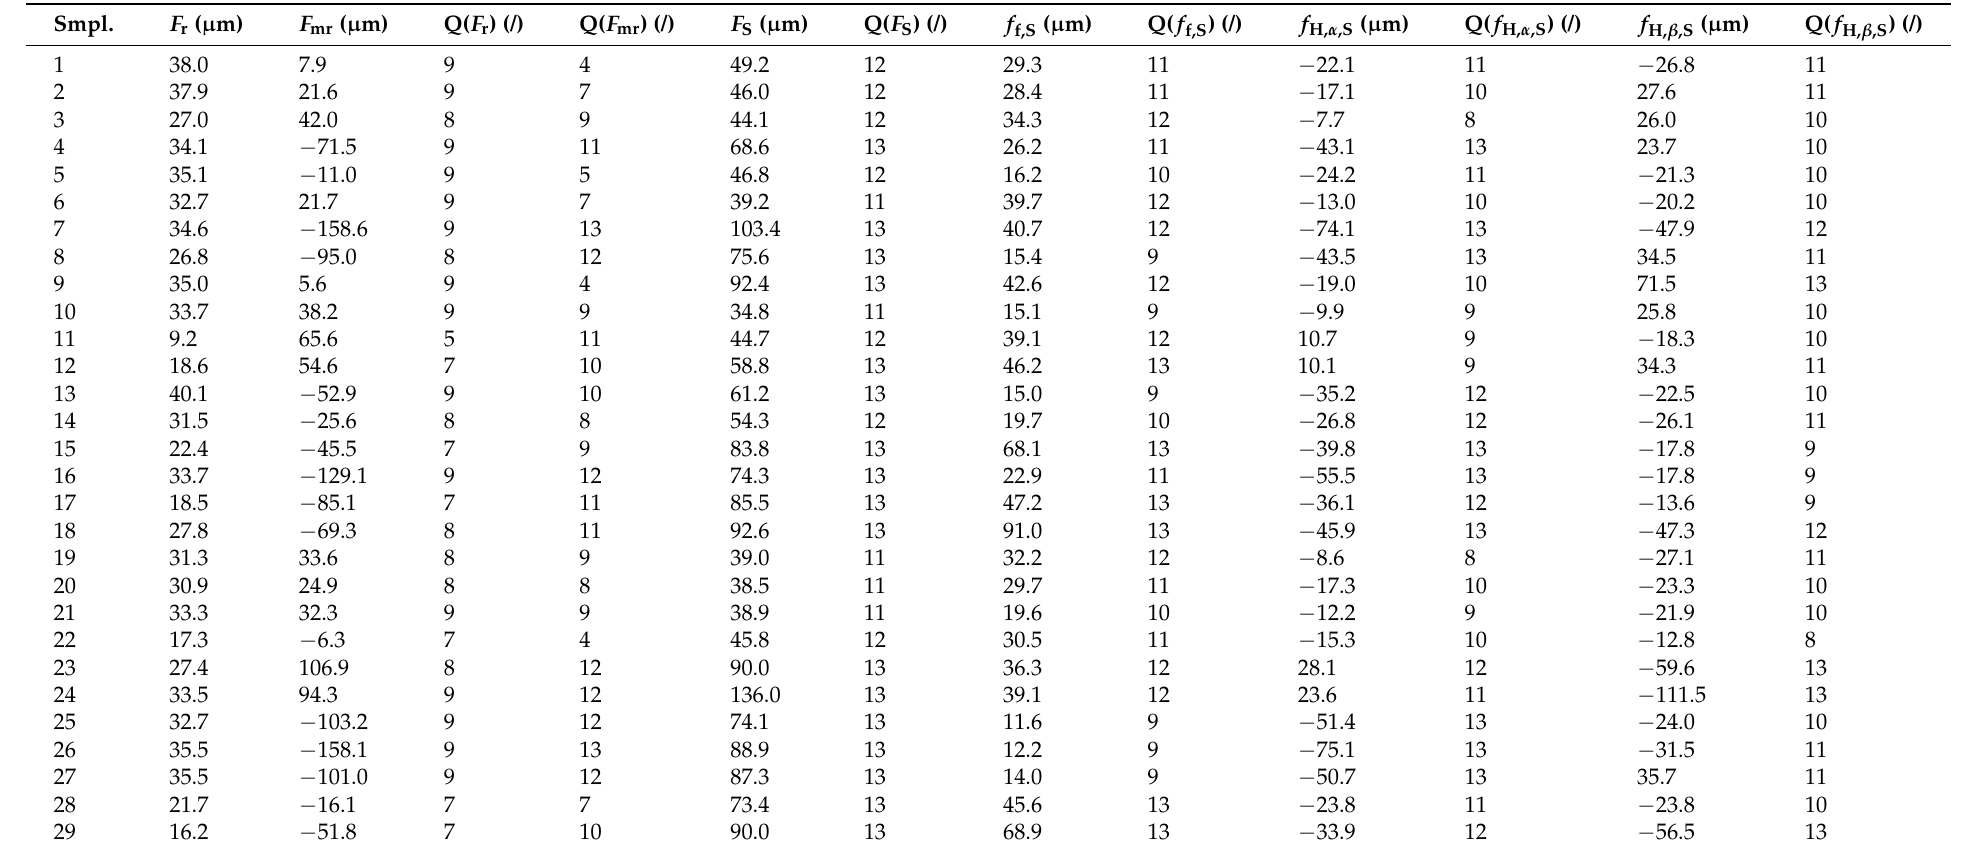
Table 4. Results of the evaluation of F r and new parameters for the upgraded geometric characterisation of injection moulded gears. The results for the areal parameters are shown for the left